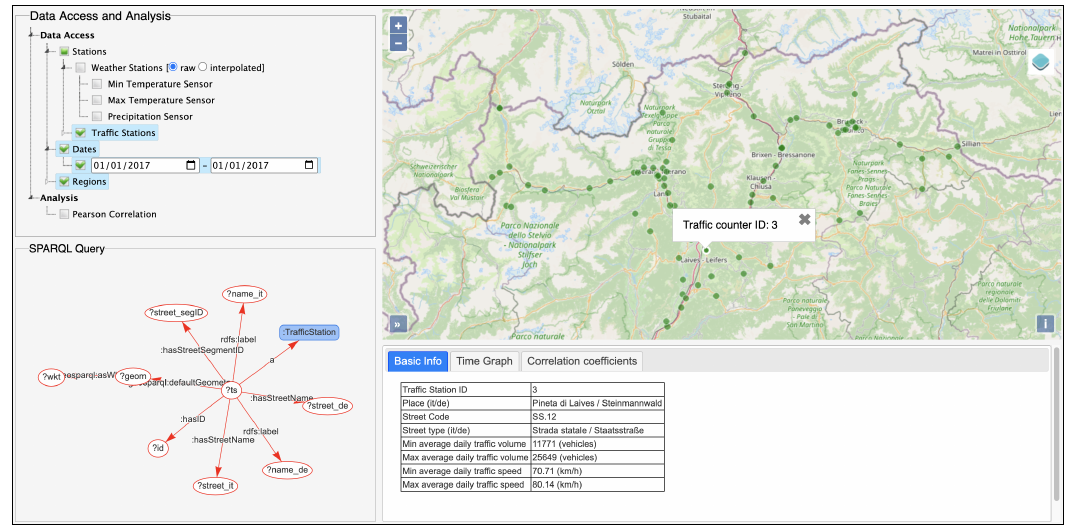
Figure 6. The visual